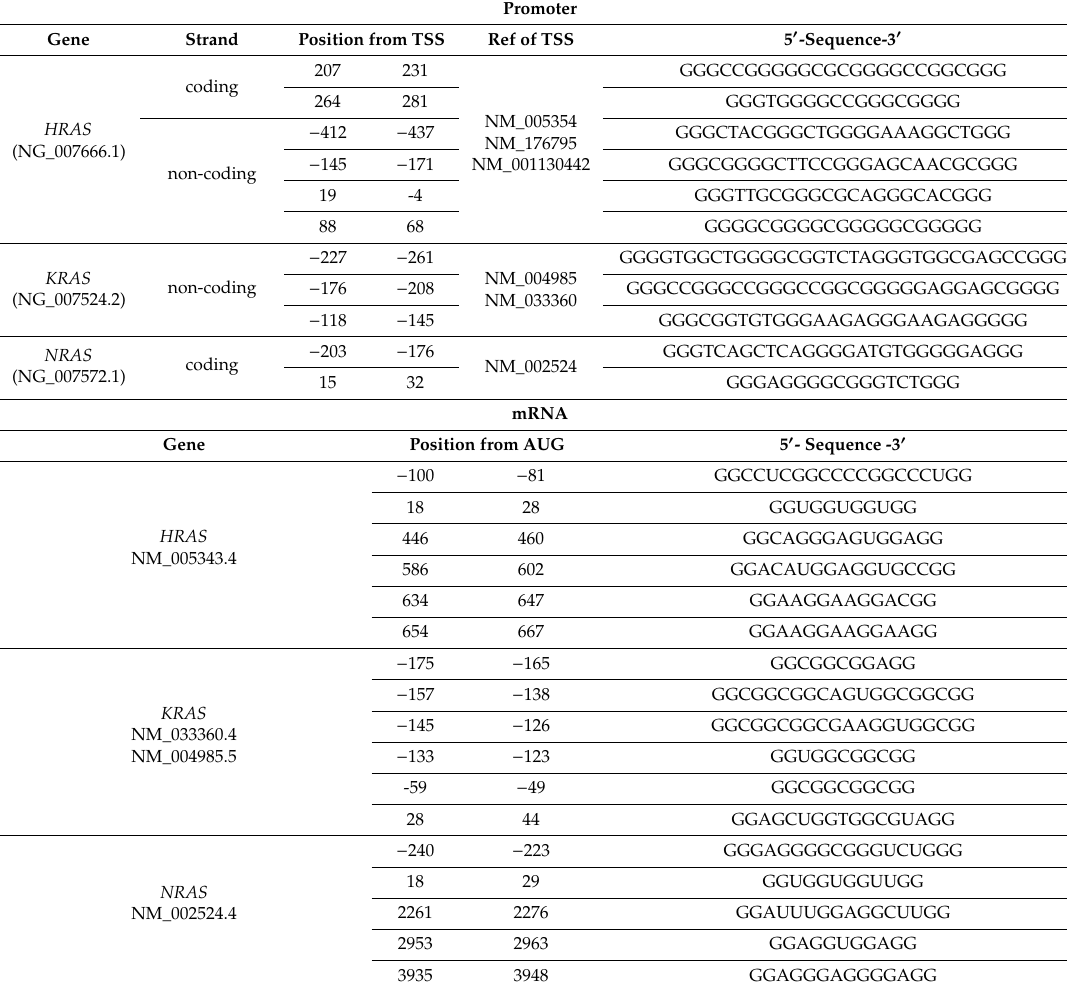
Table 1. G4 forming sequences derived from RAS promoter and